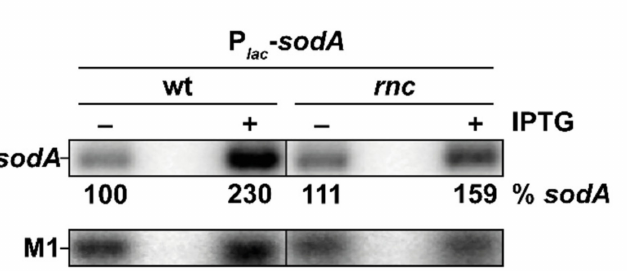
Figure 6. Transcriptional and post-transcriptional regulation of sodA by RNase III. N3433 P lac - sodA (wt) and IBPC633 P lac - sodA ( rnc ) strains with pBR lacI q expressing lacI q constitutively were induced (+) or not ( − ) with IPTG (0.1 mM) for 10 min. Total RNA was analyzed by northern blot; the membrane was probed for sodA and M1. Quantification of the sodA mRNA is given as % sodA mRNA in wt strain without IPTG.